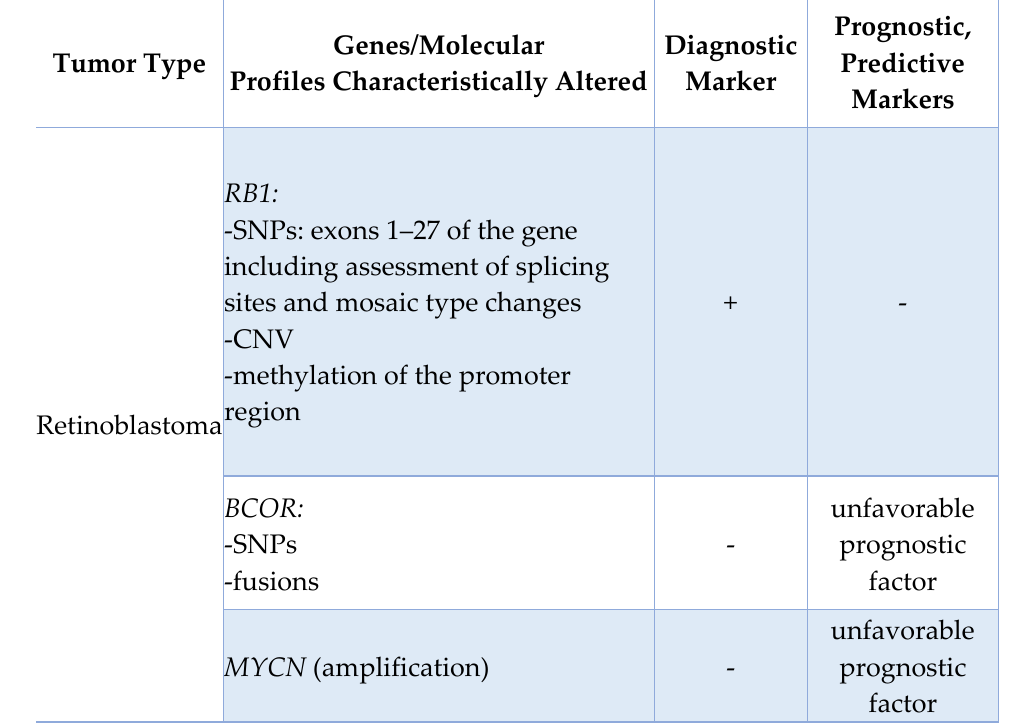
Table 8. Molecular